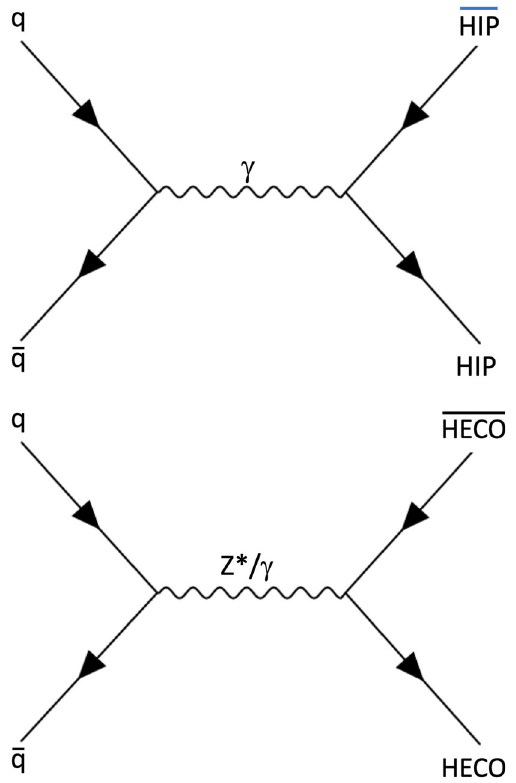
Fig. 1 Tree level Feynman diagram for DY production (top) of HIP anti-HIP pairs and (bottom) spin-1/2 HECO pairs